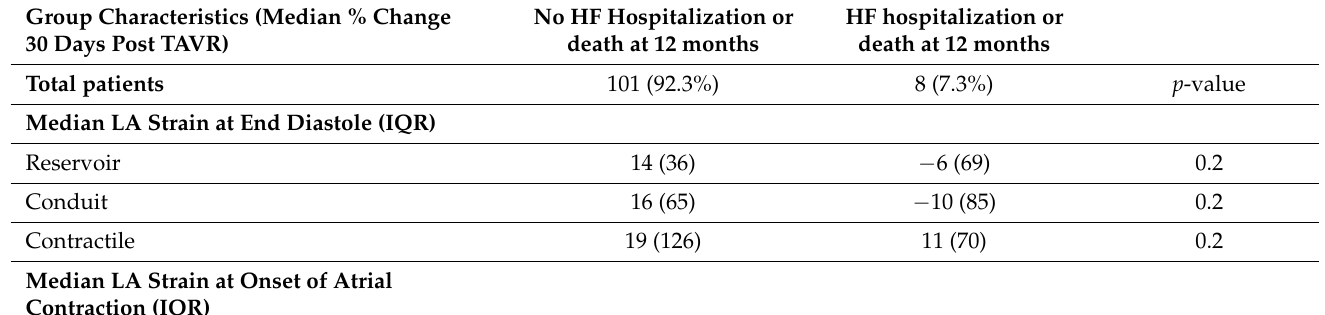
Table 6. Change in echocardiographic parameters at 30 days post-TAVR, and clinical events at 12